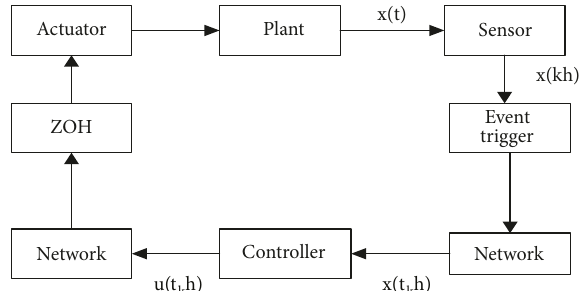
Figure 1: Schematic of networked control system with ETS.